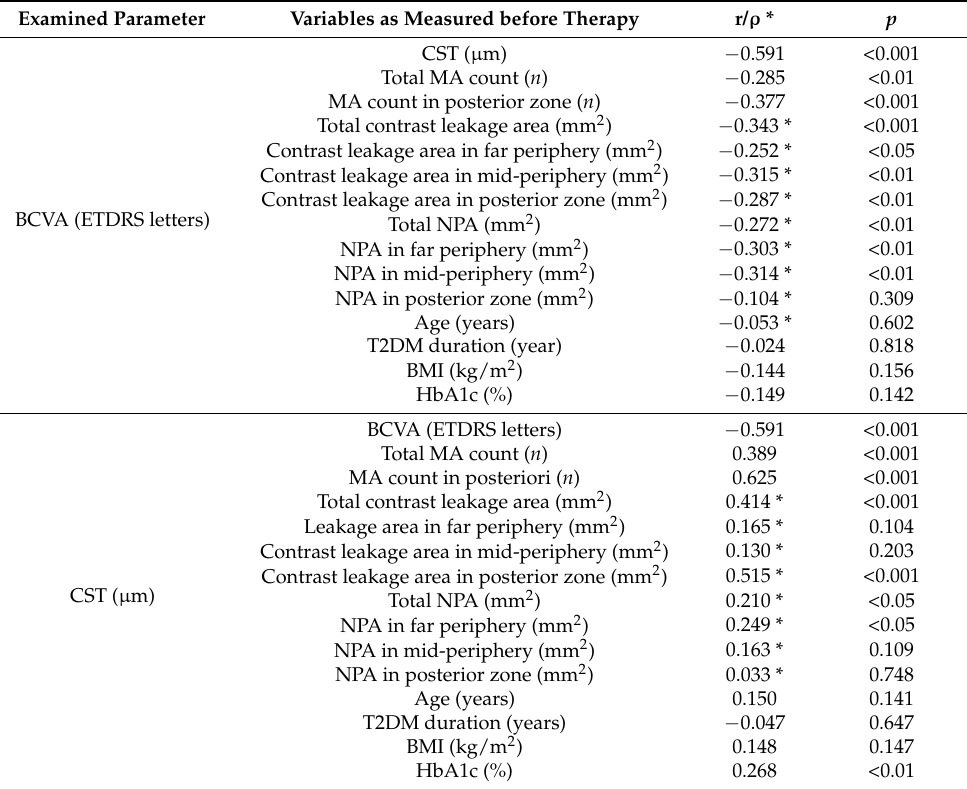
Table 3. Correlations of best-corrected visual acuity (BCVA) and macular central subfield thickness (CST) with selected variables in patients ( n = 98) with diabetic macular edema (DME) before beva- cizumab therapy. The results are expressed using r Pearson’s or ρ Spearman’s correlation coefficients. Statistical significance was set at p <